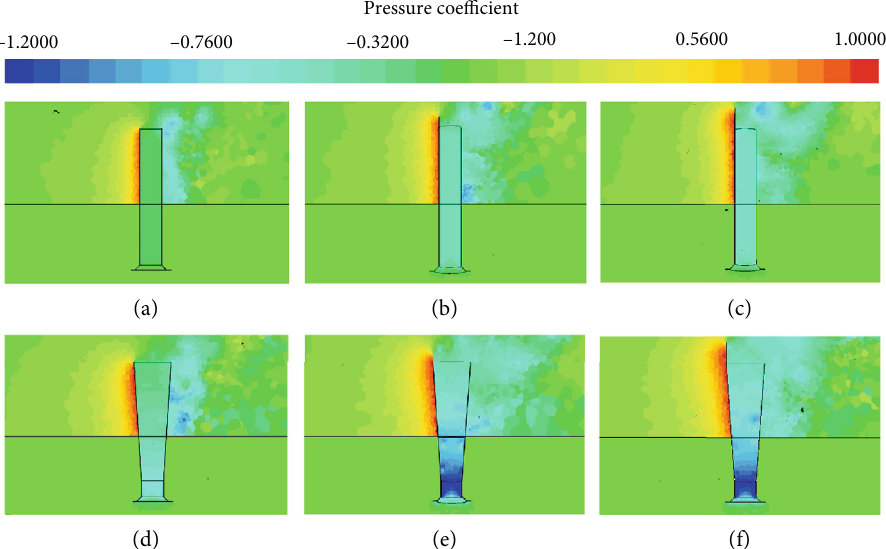
Figure 13: The time-averaged pressure distributions: (a) the cylindrical tower without the vortex generator; (b) the cylindrical tower with the = D /2 ); (c) the cylindrical tower with the vortex generator ( h vortex generator ( h vg generator; (e) the di ff user-shaped tower with the vortex generator ( h ( h = D vg